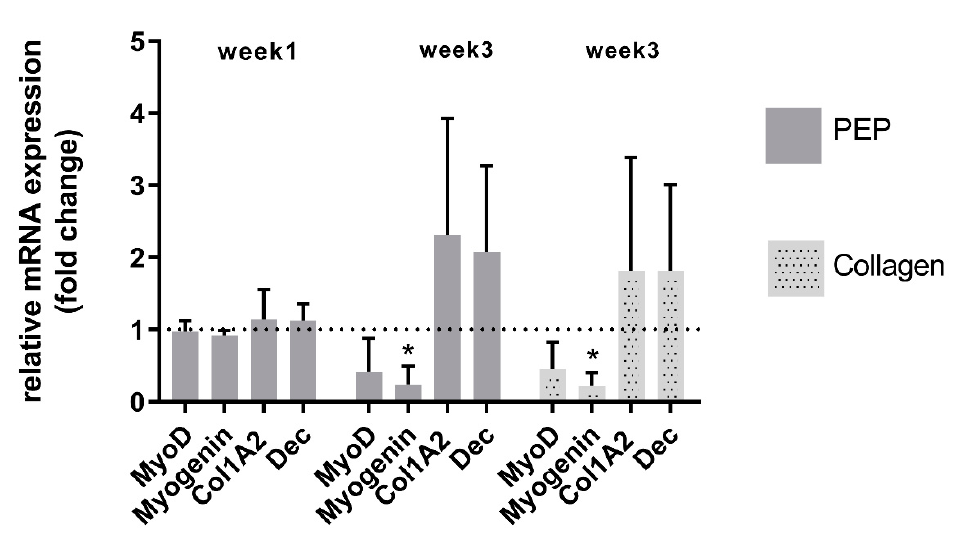
Figure 6. mRNA expression of ECM components and muscle markers of primary skeletal muscle cells cultured in a collagen scaffold with and without PEP. Skeletal ECM production of collagen (Col1A2) and decorin (Dec) was increased after three weeks of differentiation, whereas the differentiation muscle marker myogenin was reduced. Bars shows relative mRNA levels presented as a fold change ( ΔΔ Ct) in a PEP scaffold/collagen scaffold (week 1). Collagen scaffold (week 1) is set to 1 (represented as dotted line). Data are presented as mean ± stdv from three independent cell experiments seeded out in duplicates. * Significant difference compared to primary skeletal muscle cells cultured on collagen scaffold for one week determined by one-way ANOVA using Dunnett’s multiple comparison test.